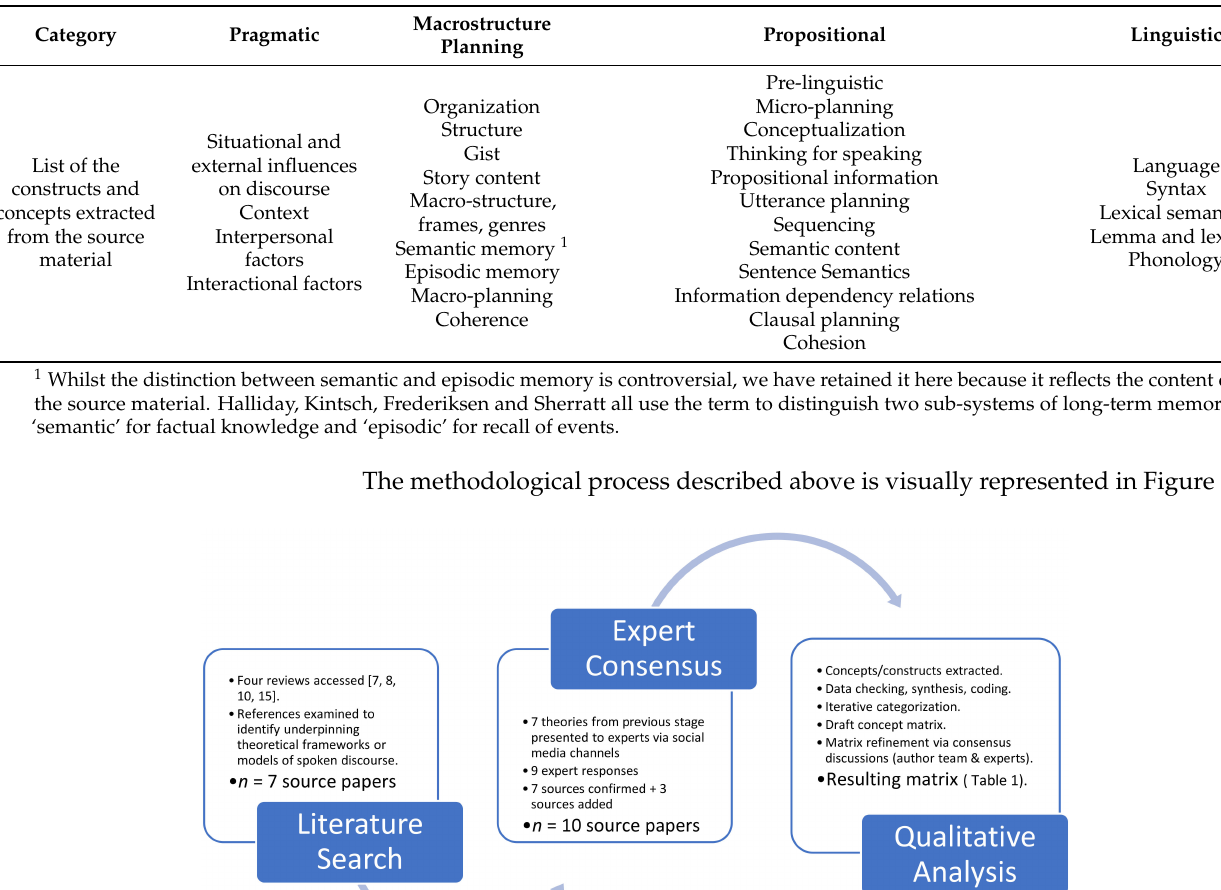
Table 1. Categorization matrix for data extracted from the spoken discourse source material.